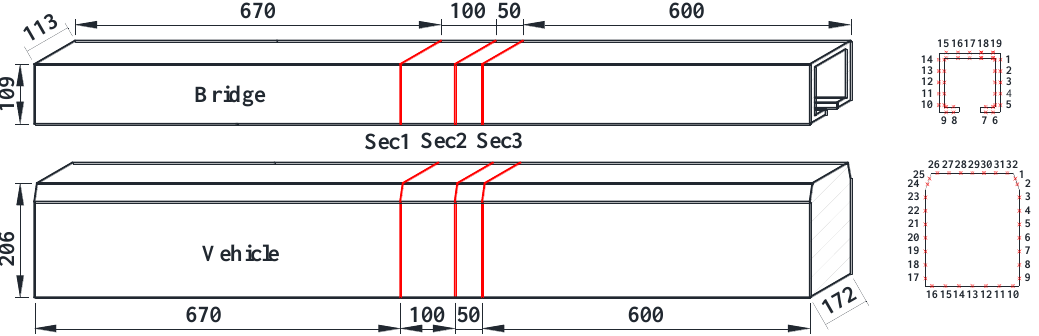
Figure 2. Dimensions of the cross-section: ( a ) Bridge; ( b ) Vehicle (unit: mm).